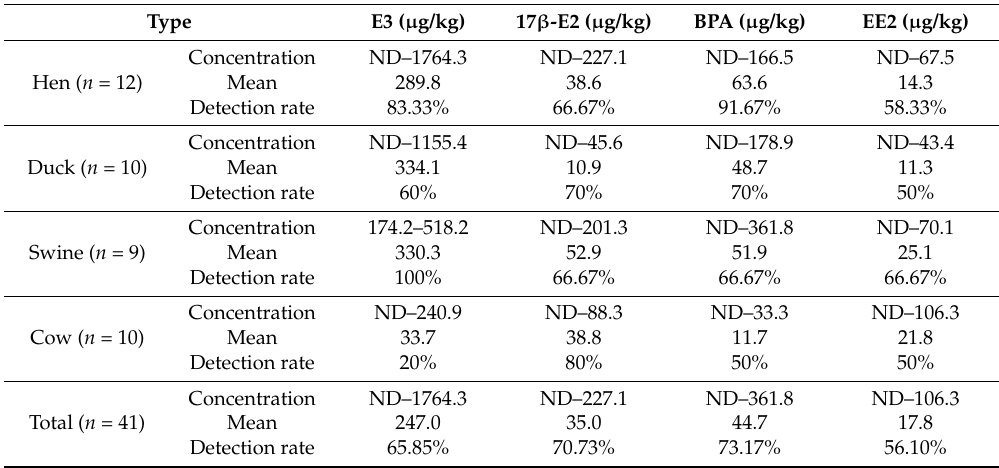
Table 2. Concentrations of estrogens in manures of hen, duck, swine and cow.